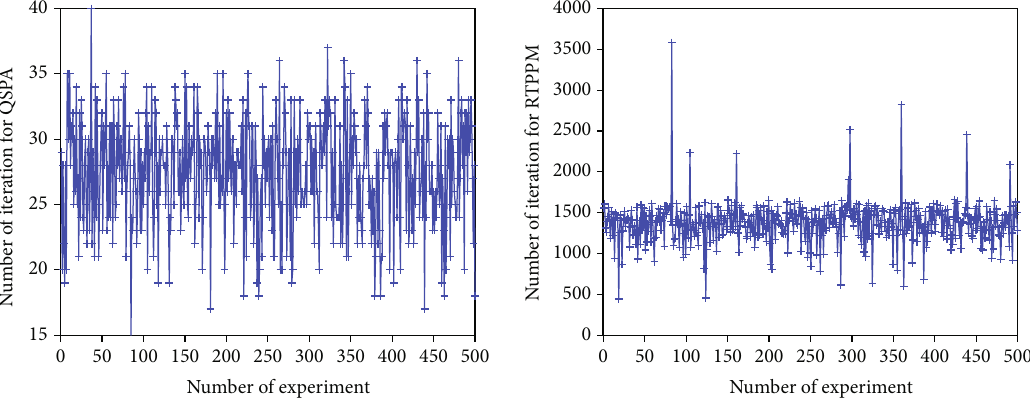
Figure 2: The iteration number of QSPA and RTPPM.